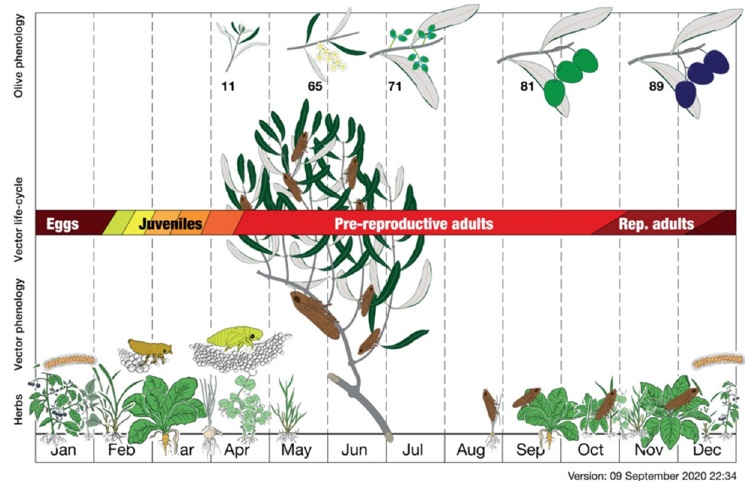
Figure 7. Philaenus spumarius life cycle related to herb and olive tree phenology. Olive phenology numbers refer to the phenological phases of olive: 11: first leaves completely separated; 65: full flowering, at least 50% of flowers open; 71: fruit size about 10% of the final size; 81: beginning of fruit coloring. 89: harvest maturity. (Reproduced from [103]).